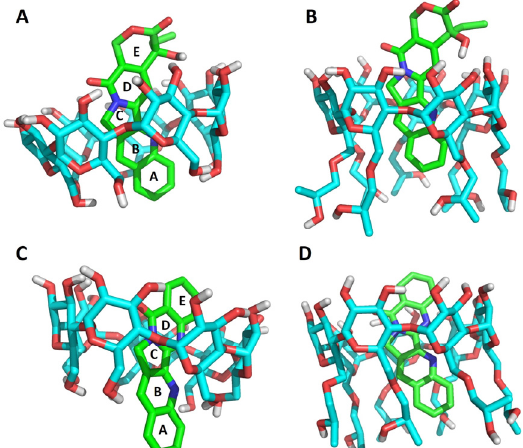
Figure 4. Docking of camptothecin and luotonin A inside the cyclodextrin cavities: ( A ) camptothe- cin– β -CD complex; ( B ) camptothecin-HP- β -CD complex; ( C ) luotonin A– β -CD complex; ( D ) luo- tonin A-HP- β -CD complex.